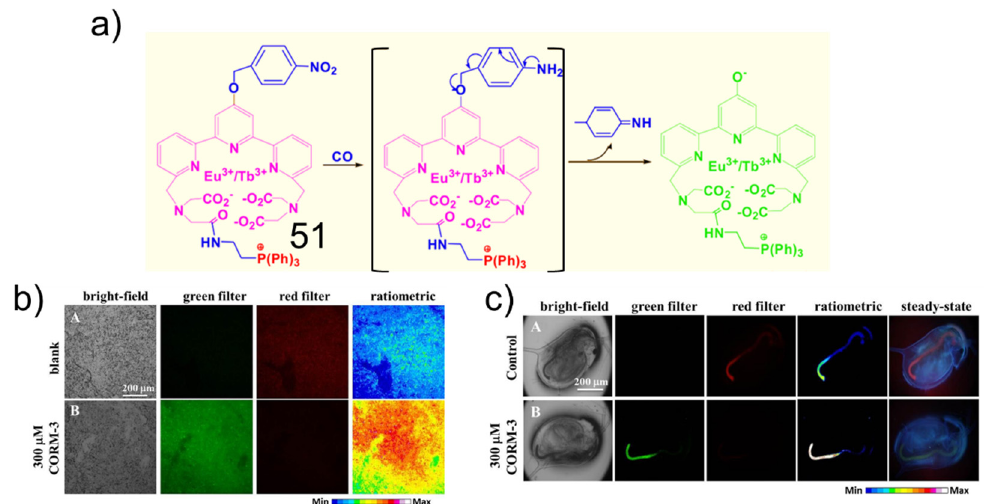
Figure 18. ( a ). The structure of probe 51 and its reaction mechanism of detecting CO. ( b ). Fluorescent images of probe for imaging CO in mouse liver tissue. ( c ) Fluorescence imaging of the probe in Daphnia magna. Copyright (2019) American Chemical Society [56].